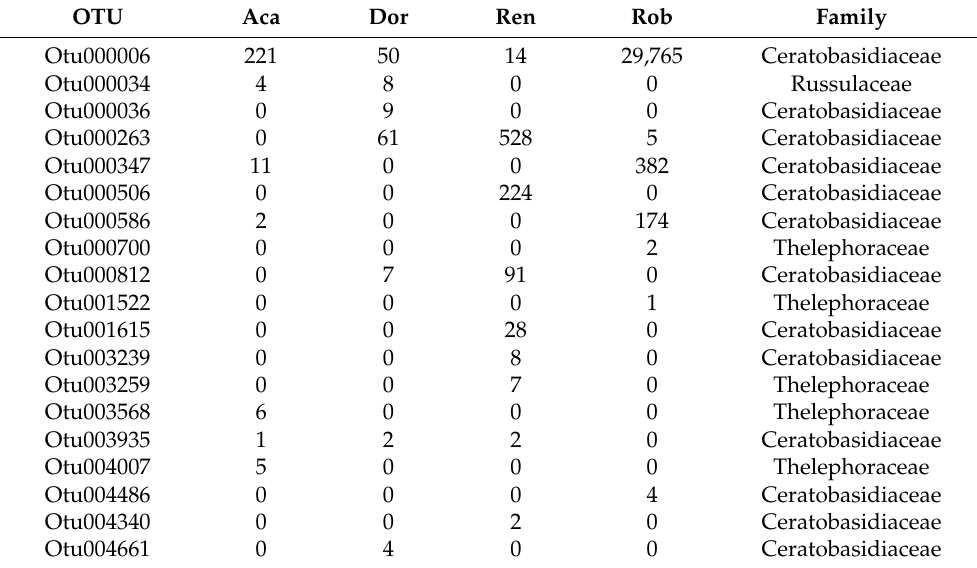
Table 2. Tag numbers of the operational taxonomic units (OTUs) corresponding to the orchid- associated mycorrhizal families